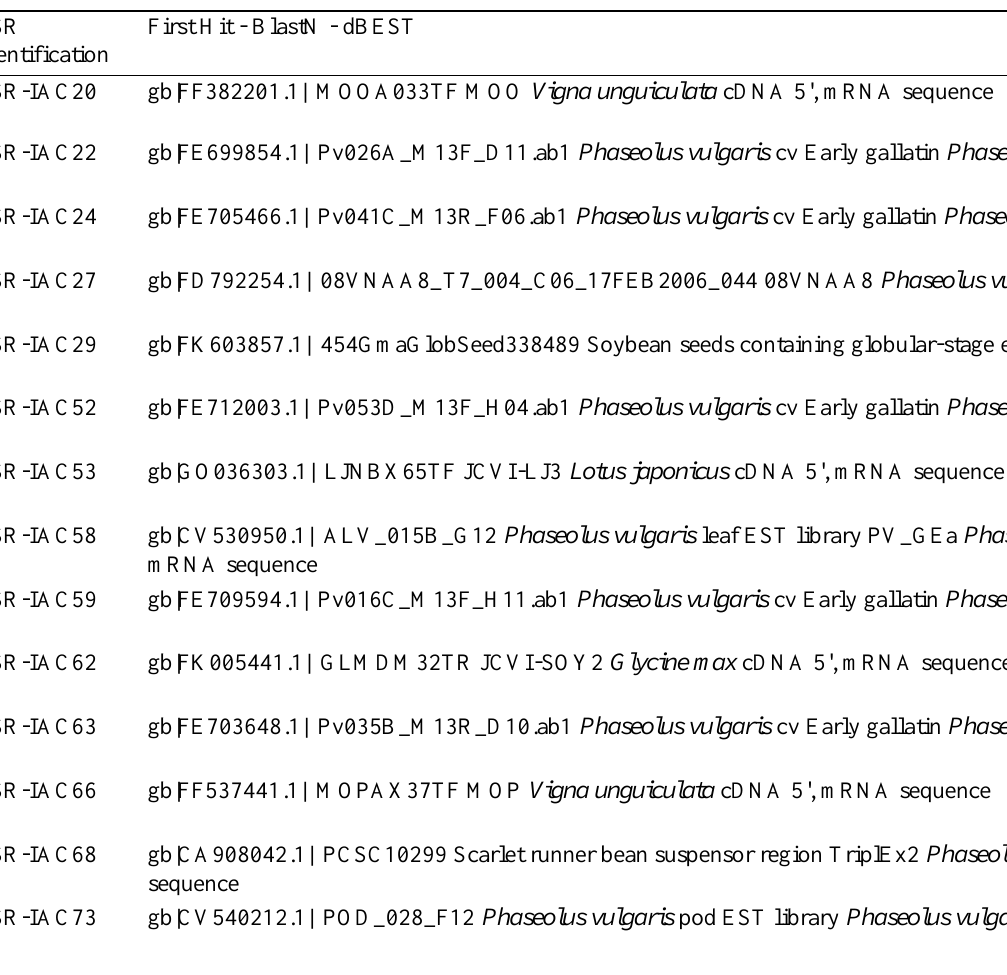
Table S2 - SSRs contains similarity with ESTs deposited in the dBEST